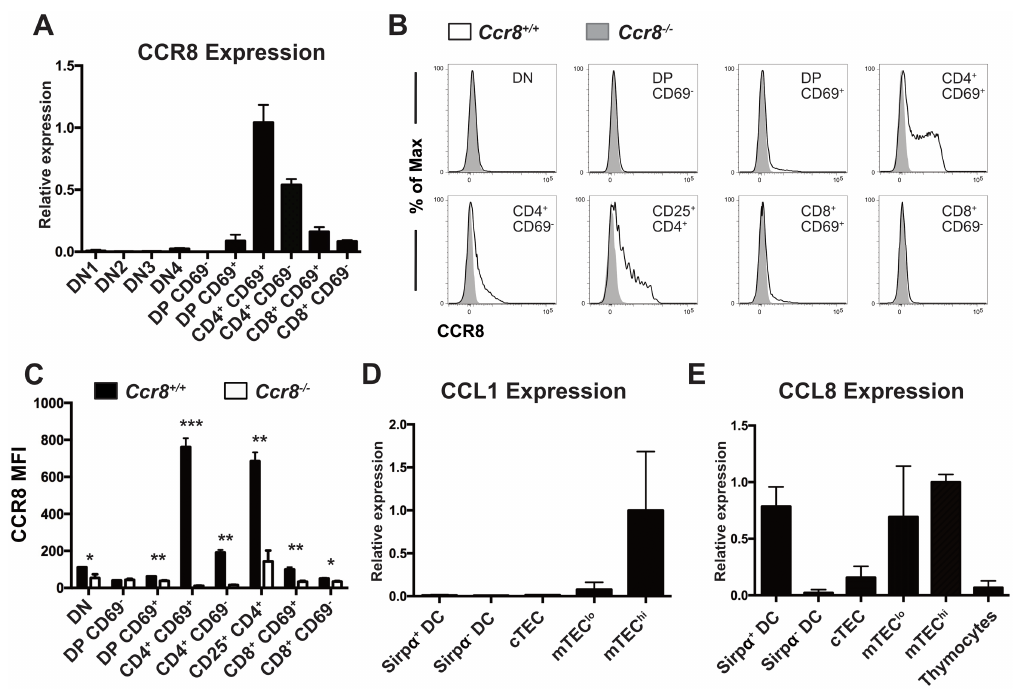
Fig 1. CCR8 is expressed by post-positive selection thymocytes, and CCR8 ligands are expressed by medullary thymic stromal cell subsets. (A) qRT-PCR analysis was used to quantify relative Ccr8 expression levels in FACS-sorted thymocyte subsets. Expression was normalized first to β -actin levels in each sample, and then between samples to expression in the CD4 + CD69 + subset. Graph shows means + SD of technical triplicates from one representative of three independent experiments. (B) Flow cytometric profiles of CCR8 cell surface expression on thymocyte subsets from Ccr8 +/+ and Ccr8 -/- mice. Data are representative of two independent experiments, with a total of six mice per genotype. (C) Quantification of CCR8 Mean Fluorescence Intensities (MFI) in Ccr8 +/+ to Ccr8 -/- thymocyte subsets, from data as in (B). Graph shows means + SD from one representative experiment with 3 mice per group; (cid:3) p < 0.05, (cid:3)(cid:3) p < 0.01, (cid:3)(cid:3)(cid:3) p < 0.001 (Unpaired two-tailed t-test with the Holm-Sidak multiple comparisons testing). (D and E) qRT-PCR analysis was used to quantify relative mRNA expression levels of the CCR8 ligands CCL1 and CCL8 in the indicated FACS-sorted thymic stromal cell subsets. Expression was normalized first to β -actin levels in each sample, and then between samples to expression in the mTEC hi subset. Graph shows means + SEM compiled from two independent experiments, each with three technical